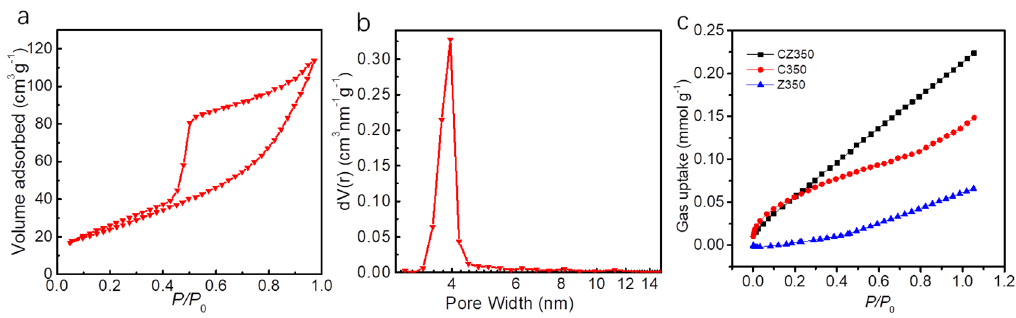
Figure 2. N 2 adsorption-desorption isotherms ( a ) and corresponding pore diameter distributions ( b ) of sample synthesized for CZ350, and CO 2 adsorption curves of CZ350, C350 and Z350 ( c ).